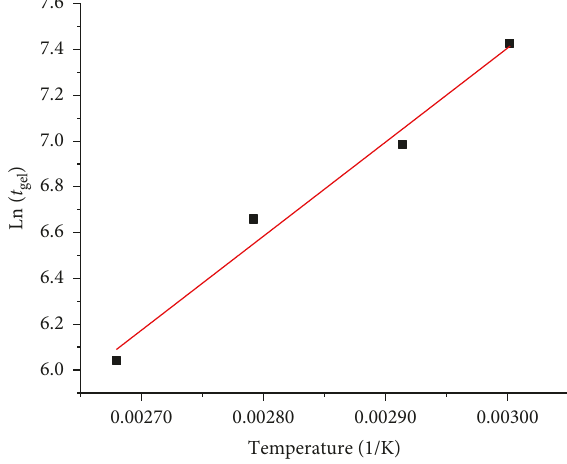
Figure 7: Resin gelation time vs.